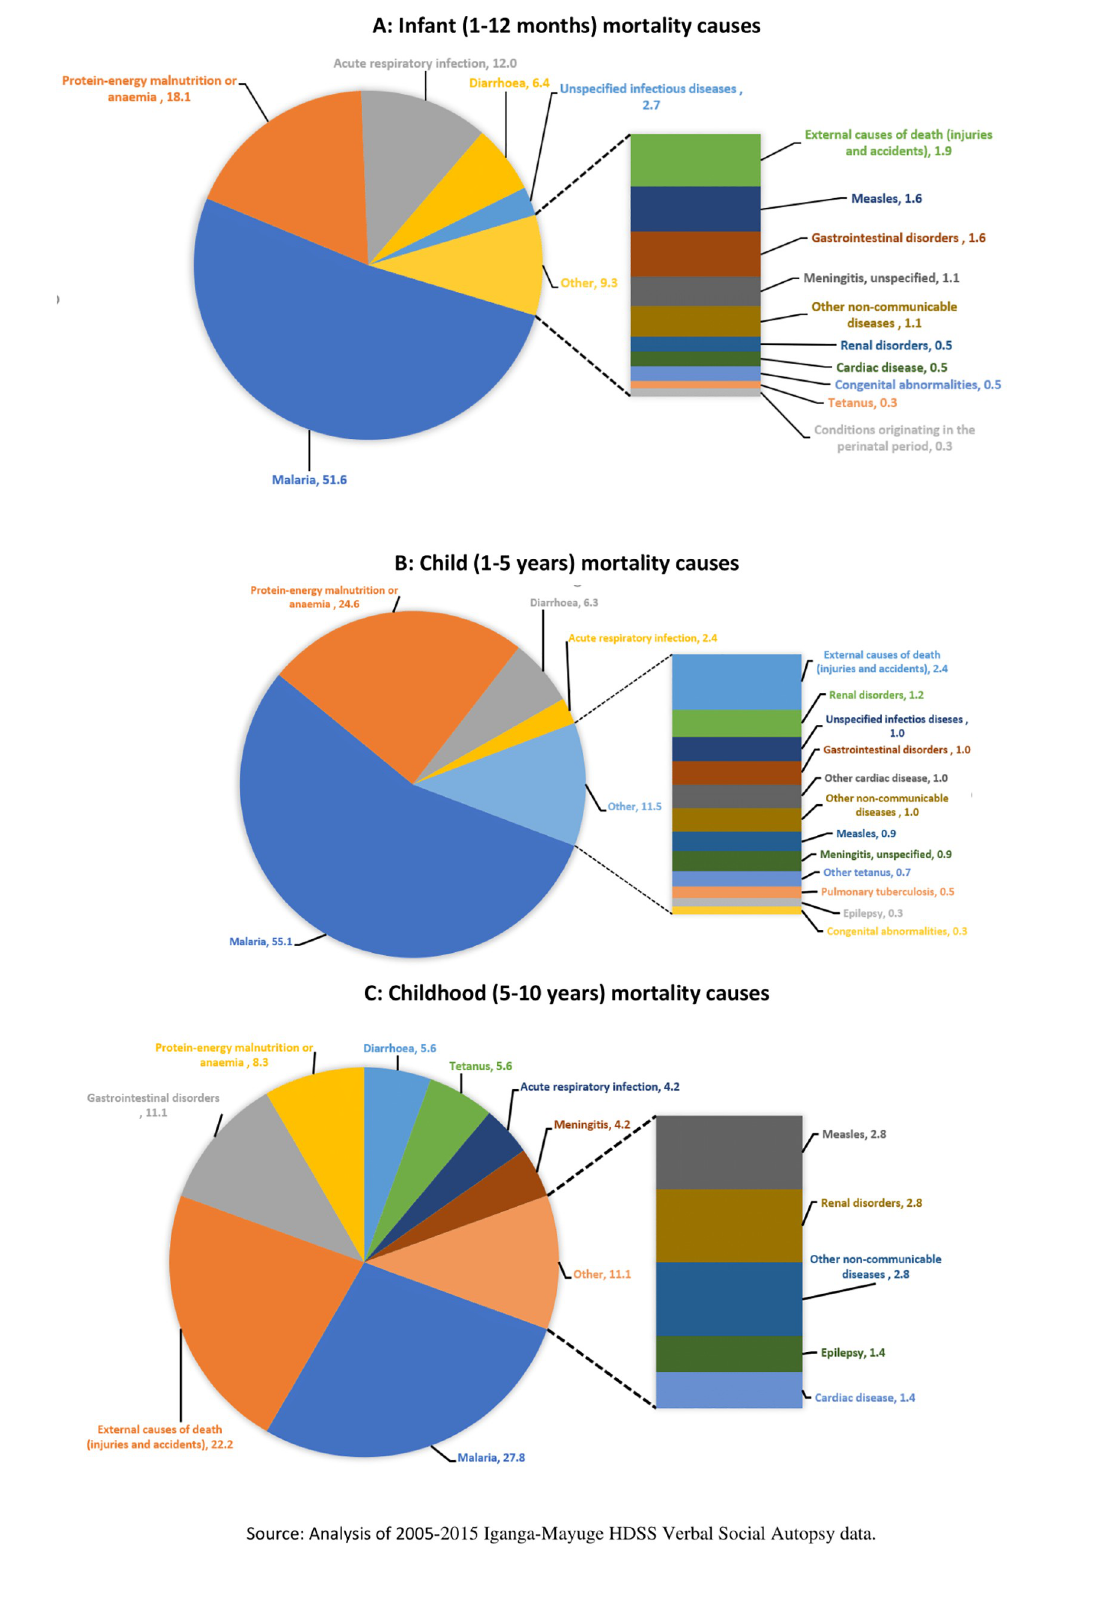
Fig 1. Under-10 mortality causes. https://doi.org/10.1371/journal.pone.0234573.g001 PLOS ONE | https://doi.org/10.1371/journal.pone.0234573 June 11,